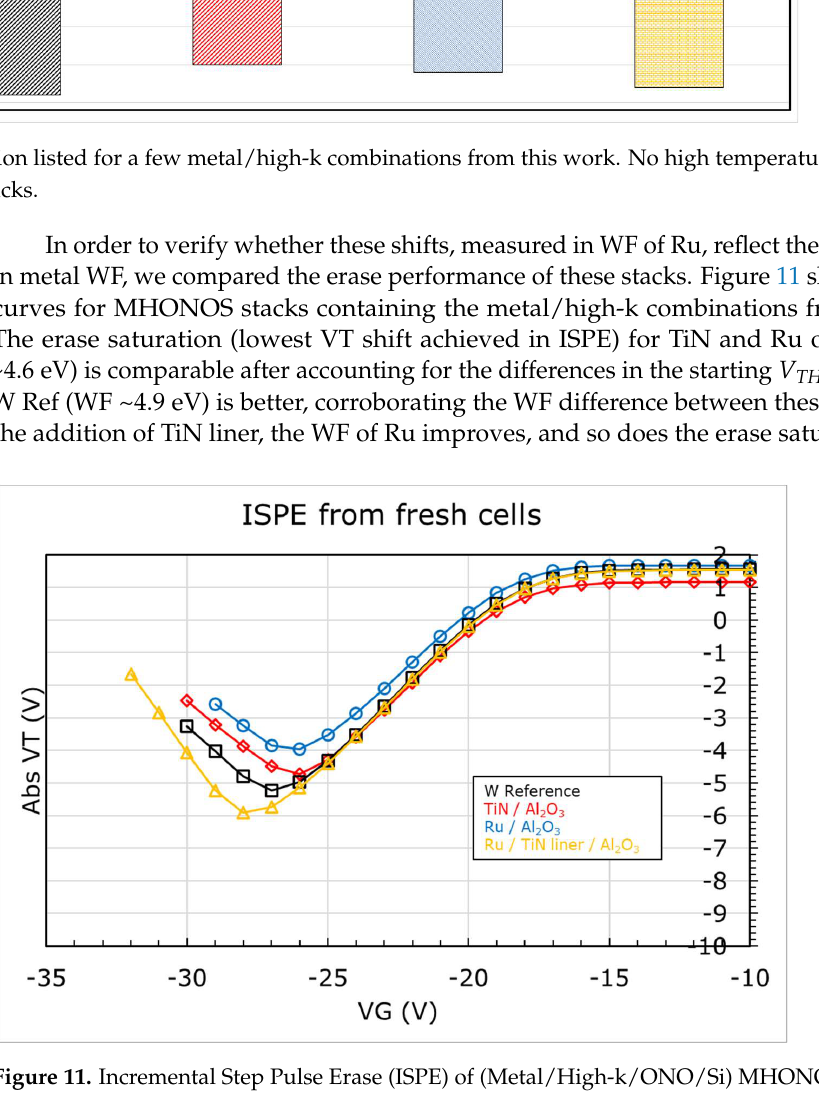
( a ) ( b ) Figure 12. WF extracted for multiple metal and high-k combinations after different annealing conditions. ( a ) Ru with HfO 2 ; ( b ) Ru, Mo with ZrO 2 , and TiN with Al 2 O 3 . ( a ) ( b )